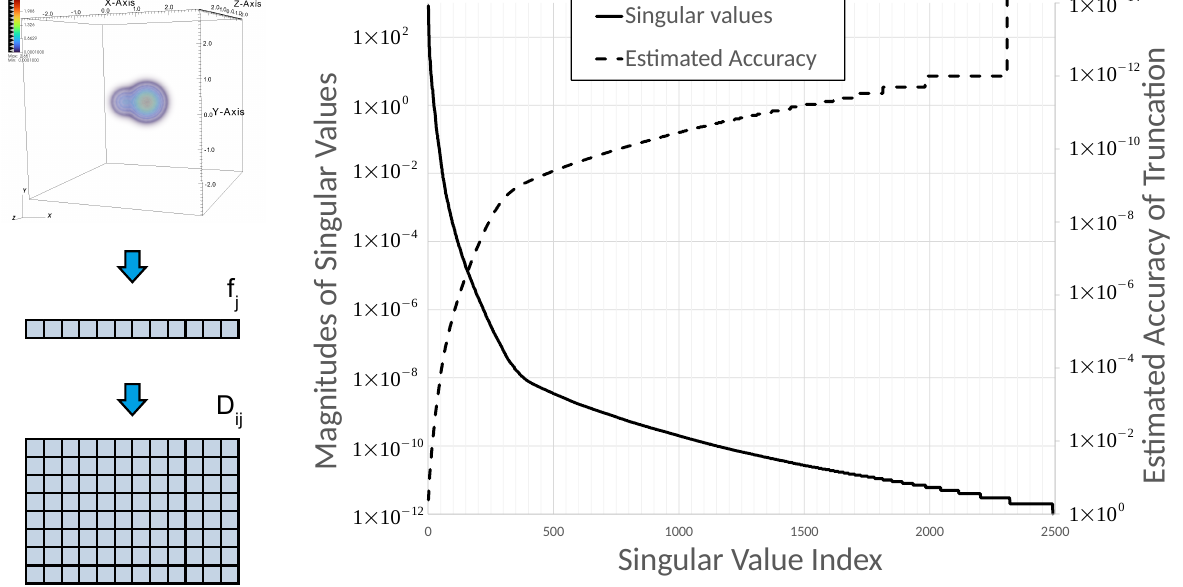
Figure 1. ( left ) Schematic depiction of constructing the solution data matrix: 3D solutions are reshaped into vectors f j which are then stacked as rows of the solution data matrix D ij . ( right ) Singular values of the solutions data matrix and estimated accuracy plotted on logarithmic